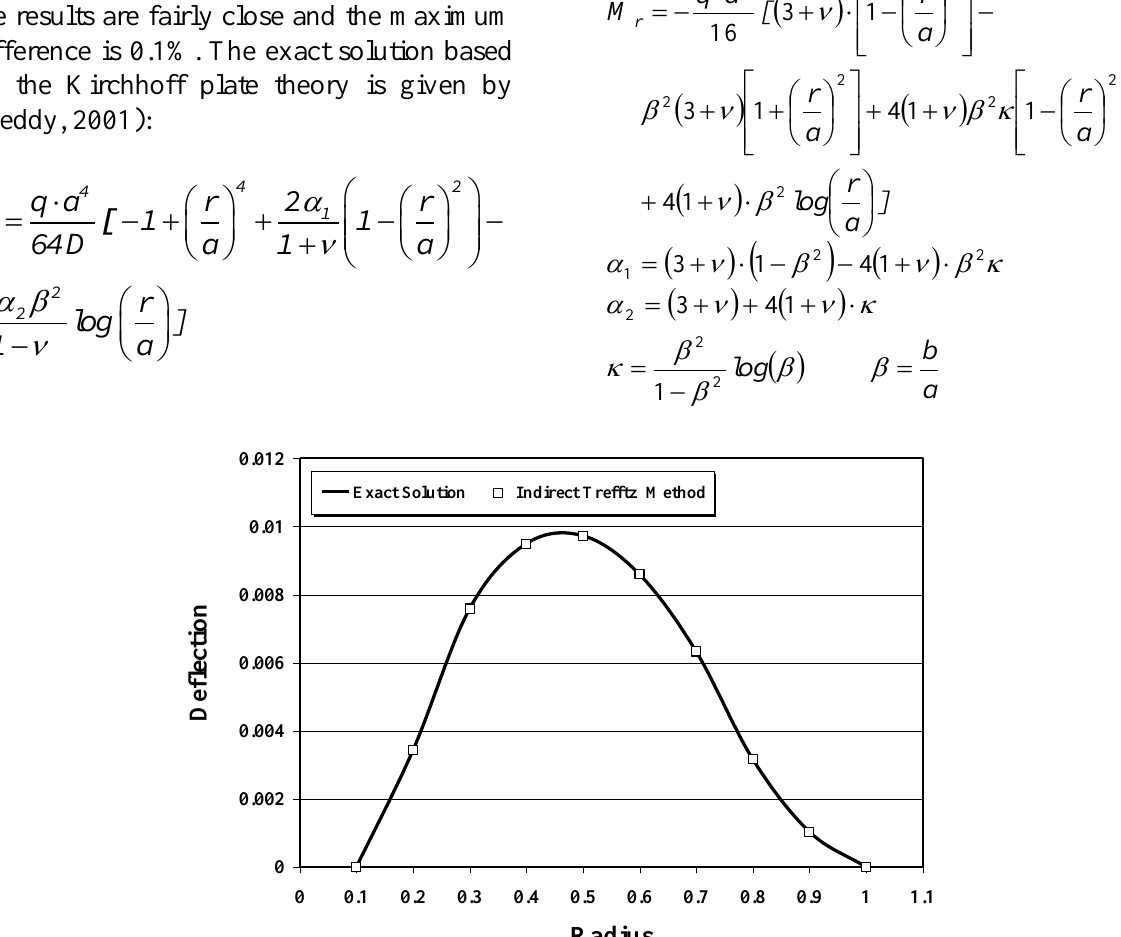
Fig. 3. Deflection along radius for simply supported annular plate ( b = 0.1 a , h = 0.02 a )